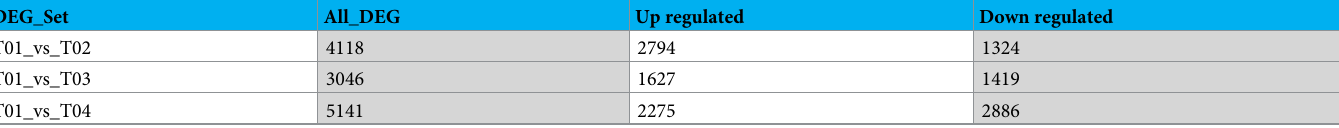
Table 1. The number of differentially expressed genes. DEG_Set